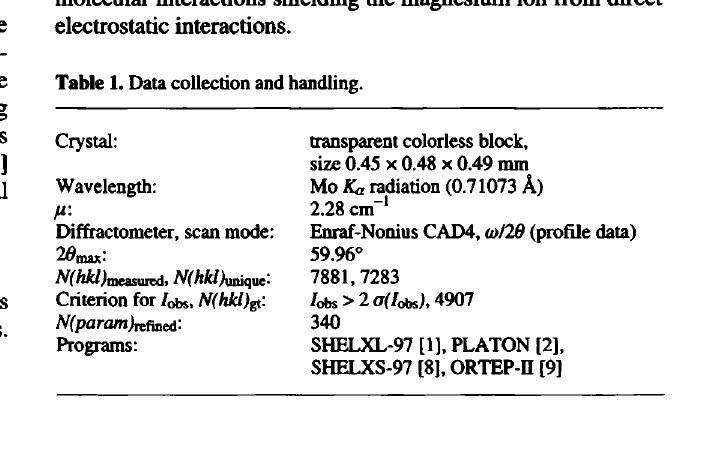
Table 1. Data collection and